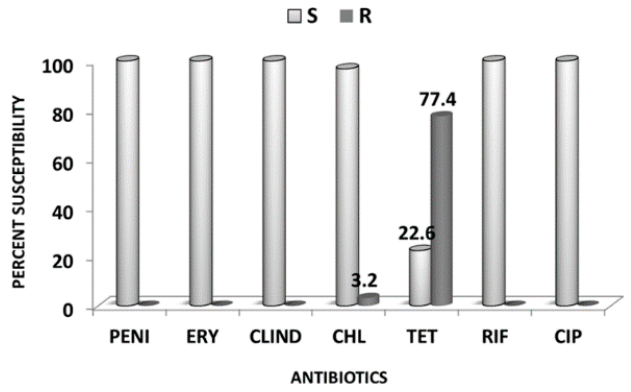
Figure 1. Percent antibiotics susceptibility levels of 31 clinical serotype1 Streptococcus pneumoniae recovered from meningitis patients during 2002–2009 meningitis surveillance in Niger. Legend: S = Susceptible; R = Resistant; PENI = Penicillin; ERY= Erythromycin; CLIND = Clindamycin; CHL = Chloramphenicol; TET = Tetracycline; CIP = Ciprofloxacin.